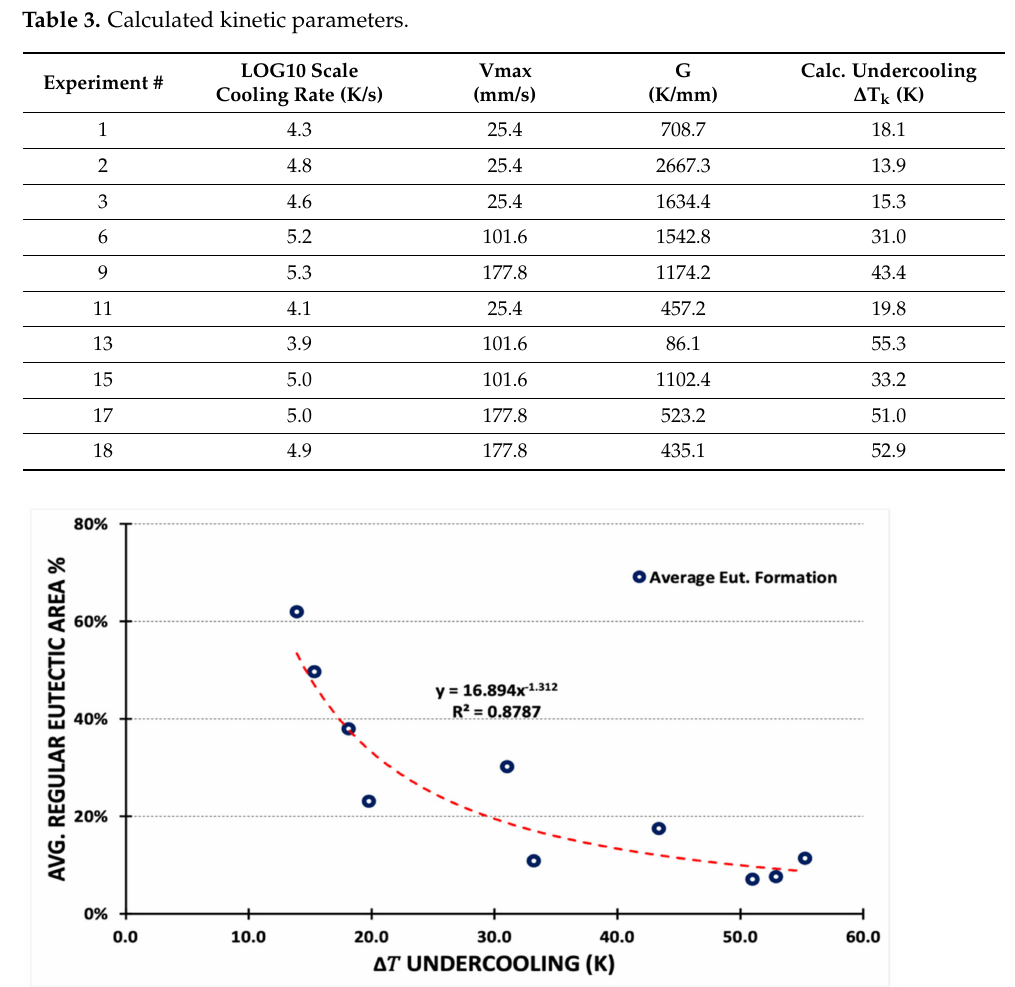
Figure 11. Average eutectic area plotted against undercooling. The red dashed line shows that eutectic area percentage correlates to undercooling with good agreement (R 2 = 0.88). This is an empirical power fit (y = 16.894x − 1.312 ) and intended to show the downward trend to the